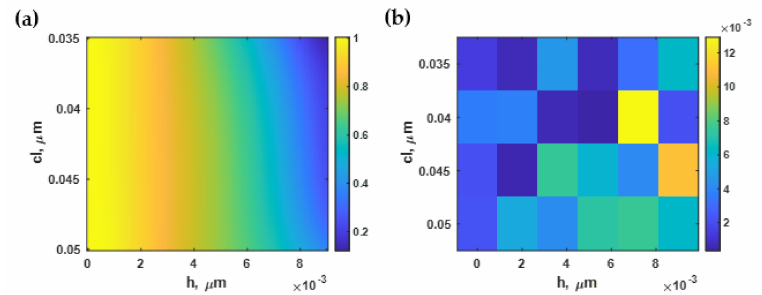
Figure 13. ( a ) The normalized intensity difference using Equation (10); and ( b ) the difference between Equation (10) and the RCWA simulation.